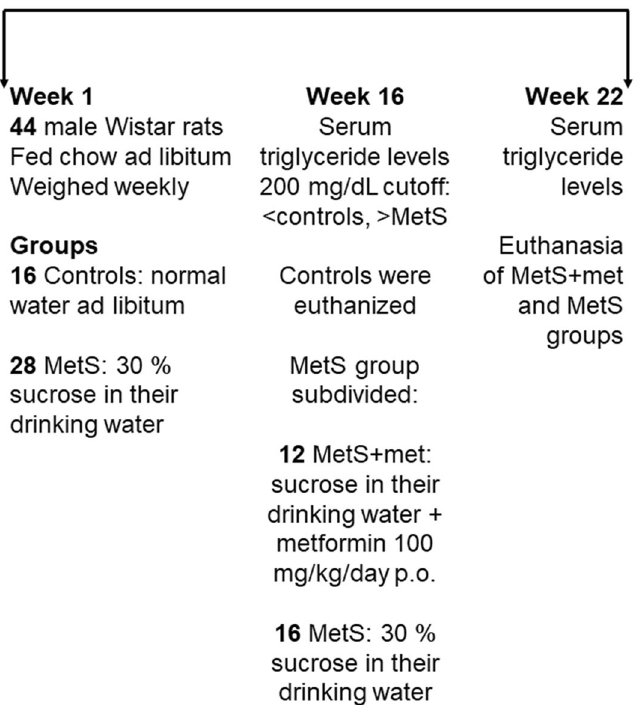
Figure 1. Timeline showing the experimental design with number of animals used (total and per group or subgroup) as well as the groups, treatments, measurement of serum triglyceride levels (which defined the inclusion into either the control or MetS groups) and animal